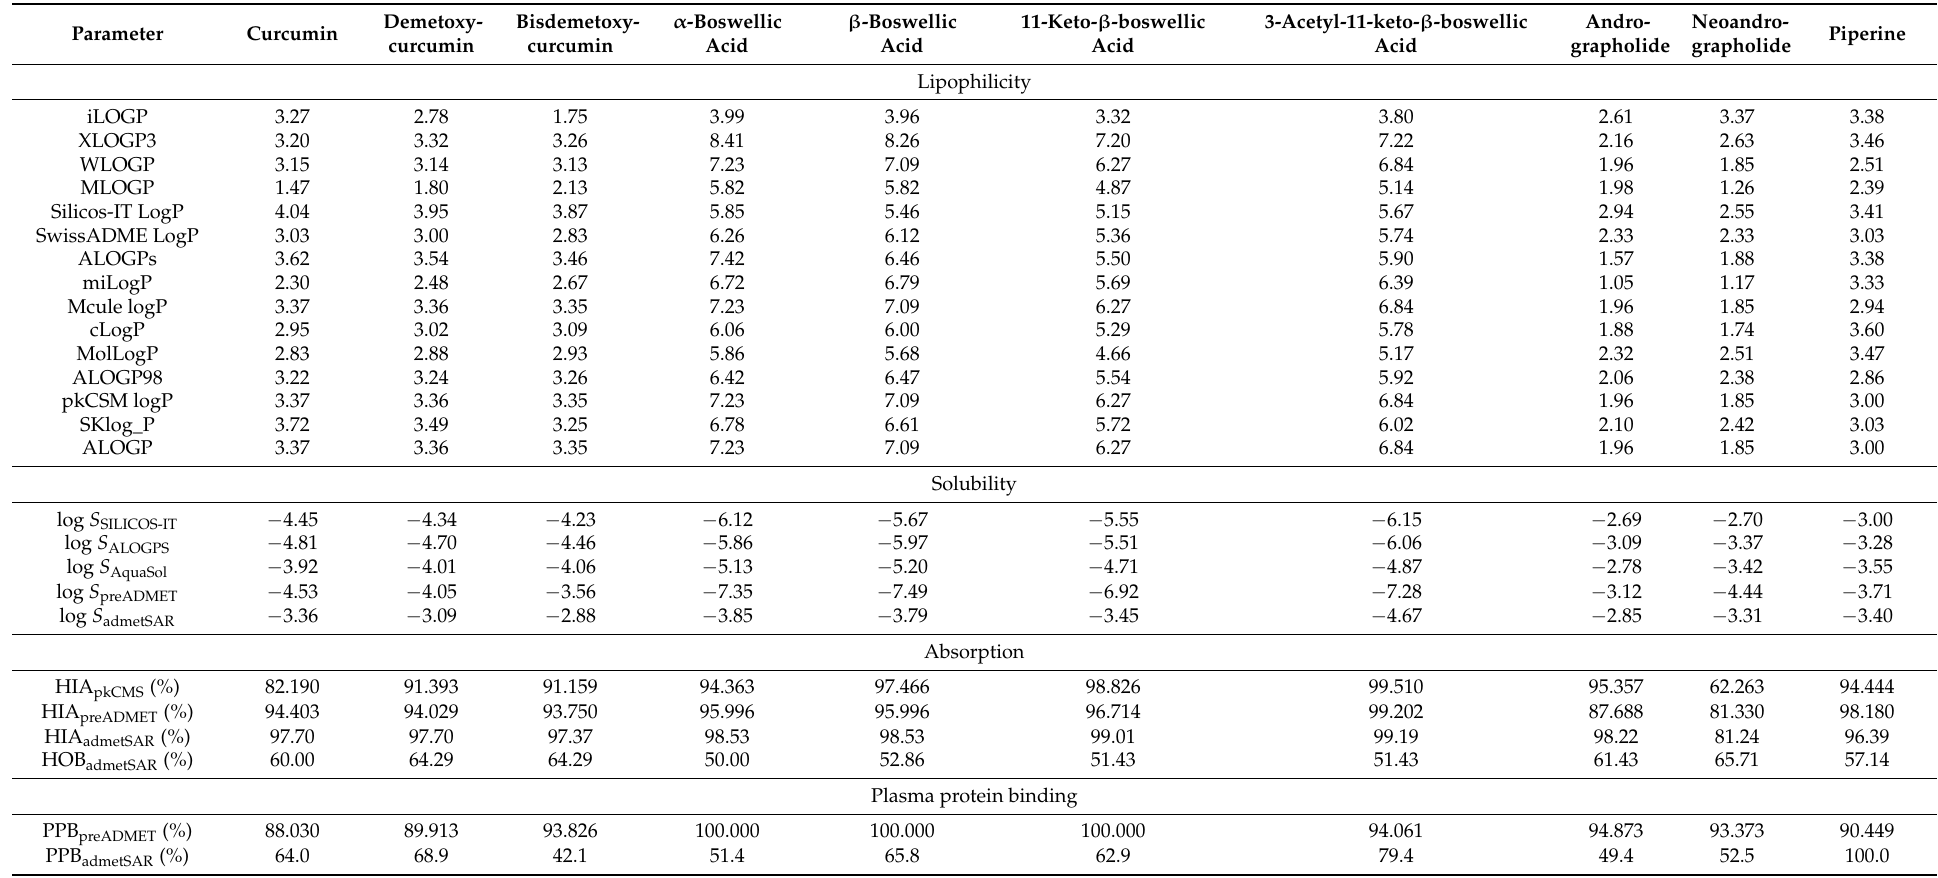
Table 1. Summary of the lipophilicity and pharmacokinetic properties obtained by theoretical approaches. Parameter